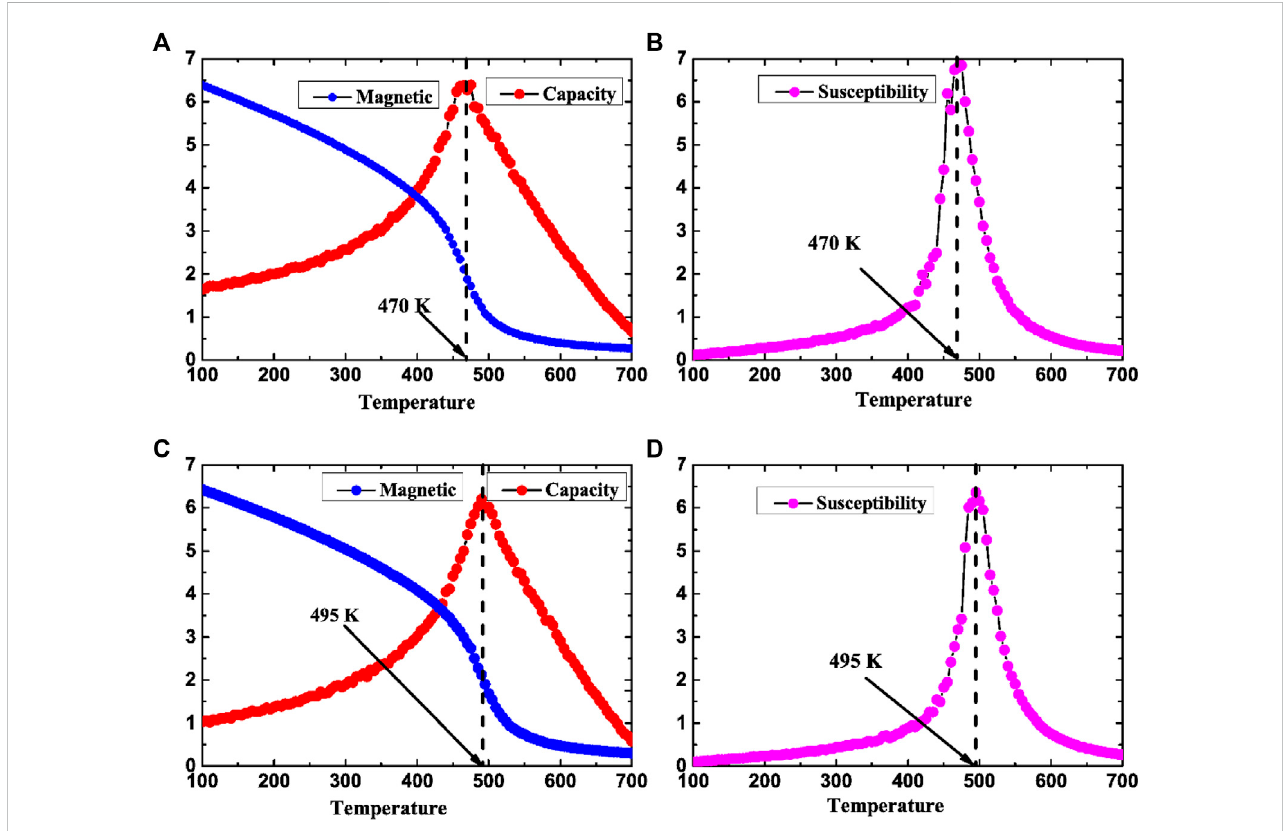
FIGURE 6 Magnetic moment (blue line), capacity (red), and magnetic susceptibility (magenta) as functions of temperature for the GdScSi monolayer (A, B) and the GdScGe (C, D) monolayer.